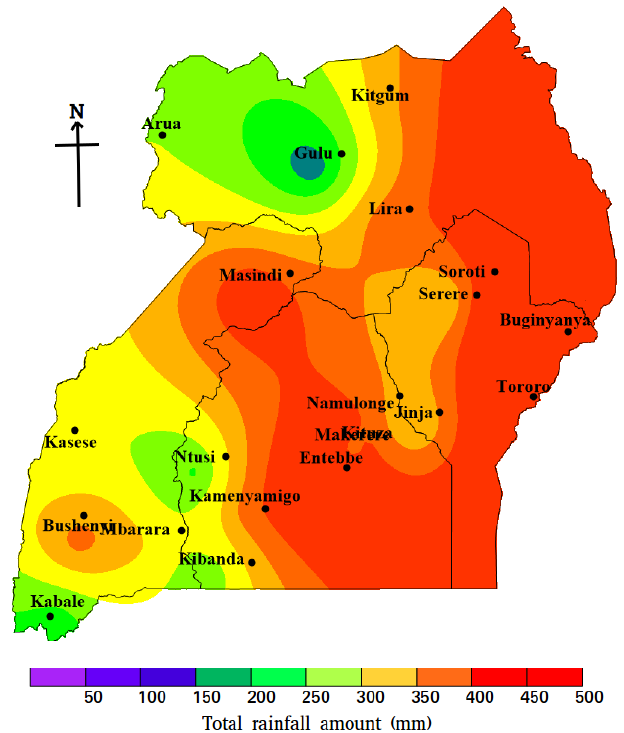
Figure 1. The figure shows the spatial total MAM 2013 seasonal rainfall patterns over the study area (Uganda). This figure is obtained using inverse distance weighted interpolation (IDW)